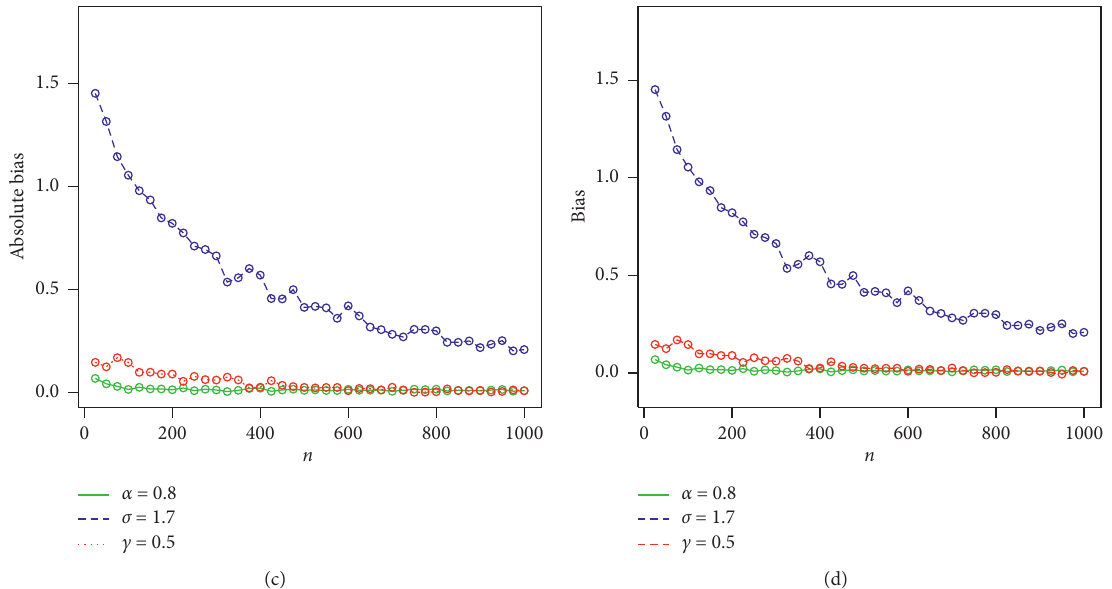
Figure 6: Plots of the estimated parameters, MSEs, absolute biases, and biases for α � 0 . 8, σ � 1 . 7 � , and c � 0 . 5. (a) Plot of estimated parameters versus n . (b) Plot of MSE versus n . (c) Plot of absolute bias versus n . (d) Plot of bias versus n